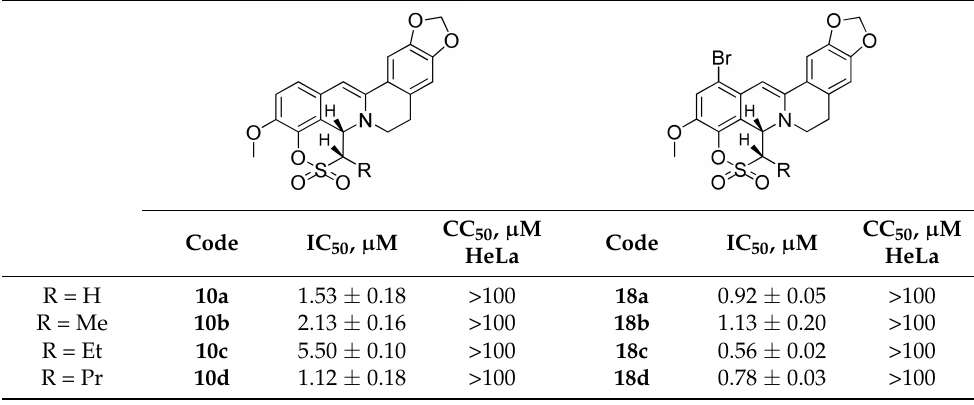
Table 1. Tdp1 inhibiting activity (IC 50 ) of berberrubine sultones and their 12-brominated analogs.